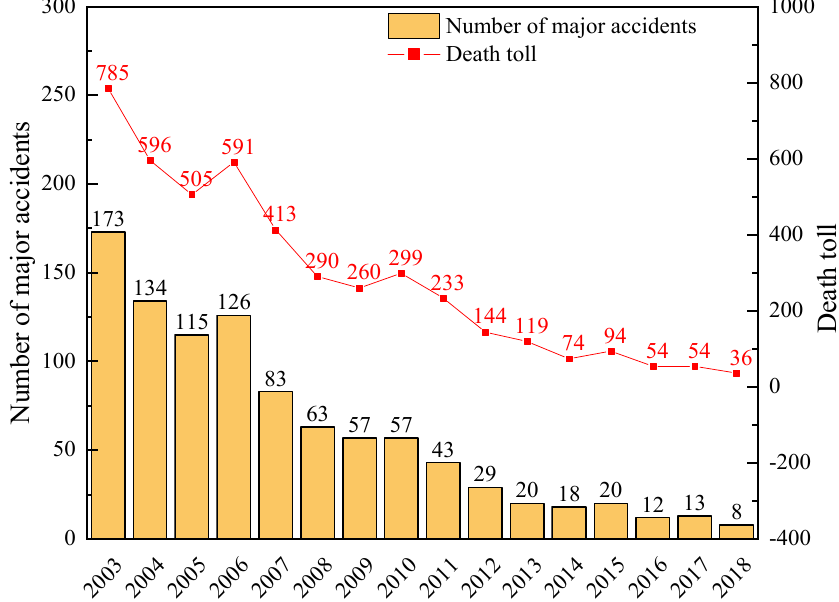
Processes 2020 , 8 , x FOR PEER REVIEW Figure 4. Changes in the number of major gas accidents and deaths. Figure 4. Changes in the number of major gas accidents and deaths.